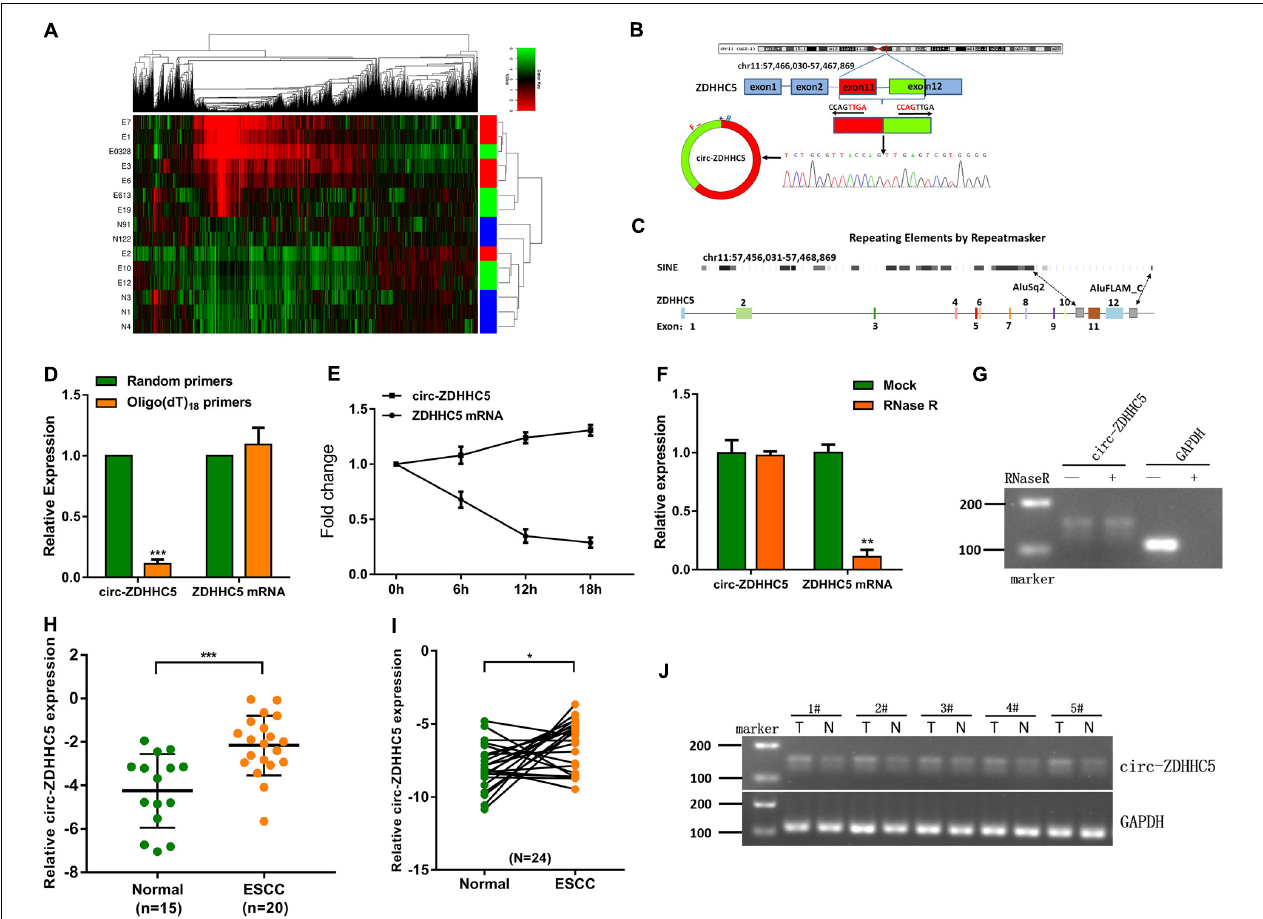
FIGURE 1 | Circ-ZDHHC5 expression increases in clinical ESCC samples. (A) Heatmap studies on circRNA microarray data showing differentially expressed circRNA in the ESCC plasma group and normal control group. (“E” represents patient samples, and “N” represents normal control samples. “Red” represents a high level of expression, and “green” represents a low level). (B) The spliced mature sequence length of circ-ZDHHC5 originated from the ZDHHC5 gene. (C) The genomic regions of ZDHHC5 exons 11 and 12 containing flanking Alu repeats and multiple SINEs are distributed upstream of exon 11 and downstream of exon 12. (D) circ-ZDHHC5 expression was noticeably downregulated with the Oligo (dT) 18 primer. (E) circ-ZDHHC5 had better resistance to actinomycin D than mRNA. (F) circ-ZDHHC5 had better resistance to RNase R than mRNA. (G) The agarose gel electrophoresis of circ-ZDHHC5 in ESCC cells. (H) circ-ZDHHC5 expression in ESCC plasma and normal plasma. (I) circ-ZDHHC5 expression in ESCC tissues and adjacent non-cancerous tissues. (J) circ-ZDHHC5 was performed by agarose gel electrophoresis in five pairs of tissues, and were normalized to GAPDH. (* p < 0.05, *** p <